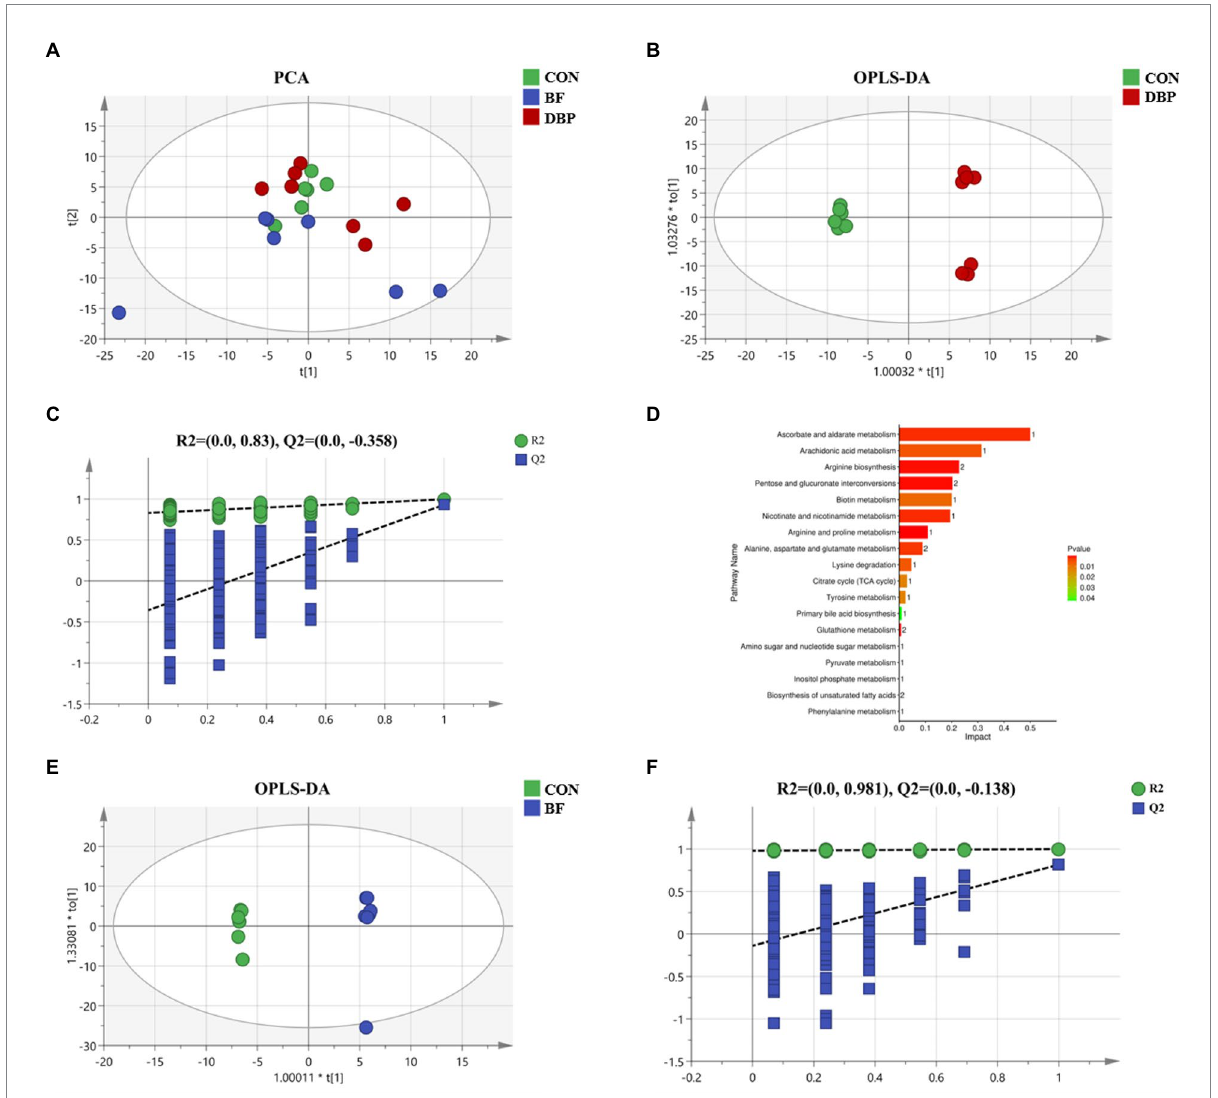
FIGURE 4 Effects of DBP and BF on fecal metabolites in dogs. PCA of fecal metabolites among the three groups (A) . OPLS-DA plot of fecal metabolites between the CON group and DBP group (B) , or the BF group (E) , in dogs. RPT between the CON group and the DBP group (C) , or the BF group (F) , in dogs. KEGG metabolic pathways enrichment analysis based on differential fecal metabolites after DBP treatment compared with group (D)